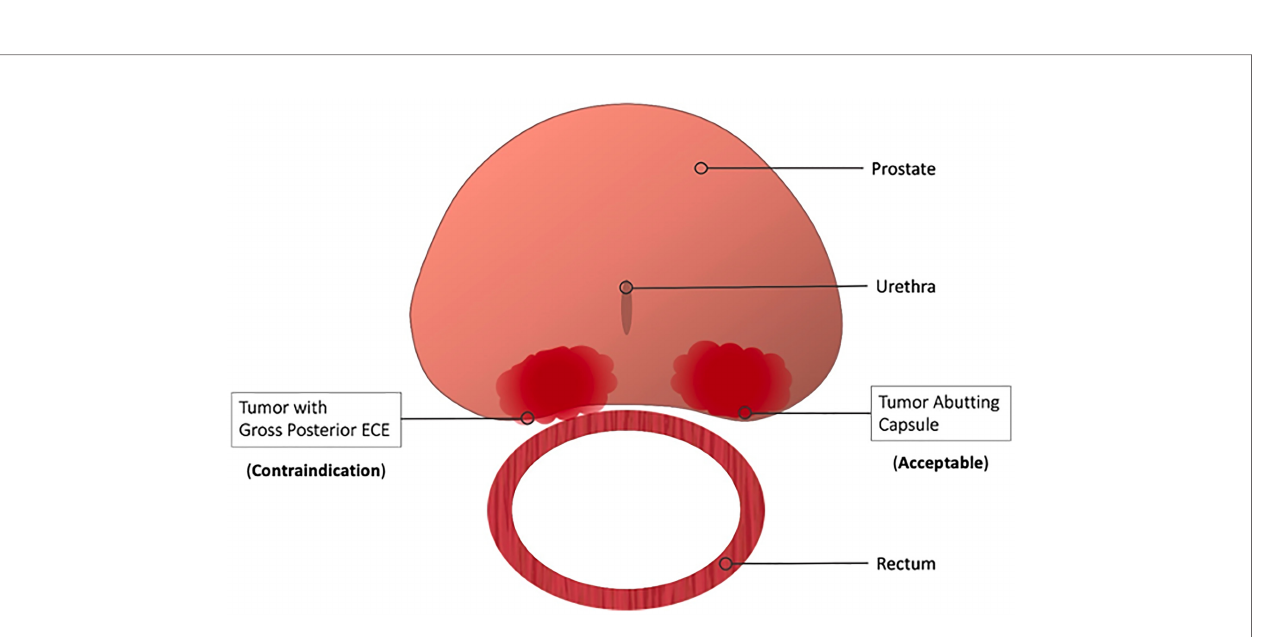
FIGURE 5 | Contraindications to Hydrogel Rectal Spacer Placement. Most practitioners consider gross or radiographic posterior ECE a contraindication to spacer placement. Contrarily, spacer placement is acceptable in those patients with capsular abutment